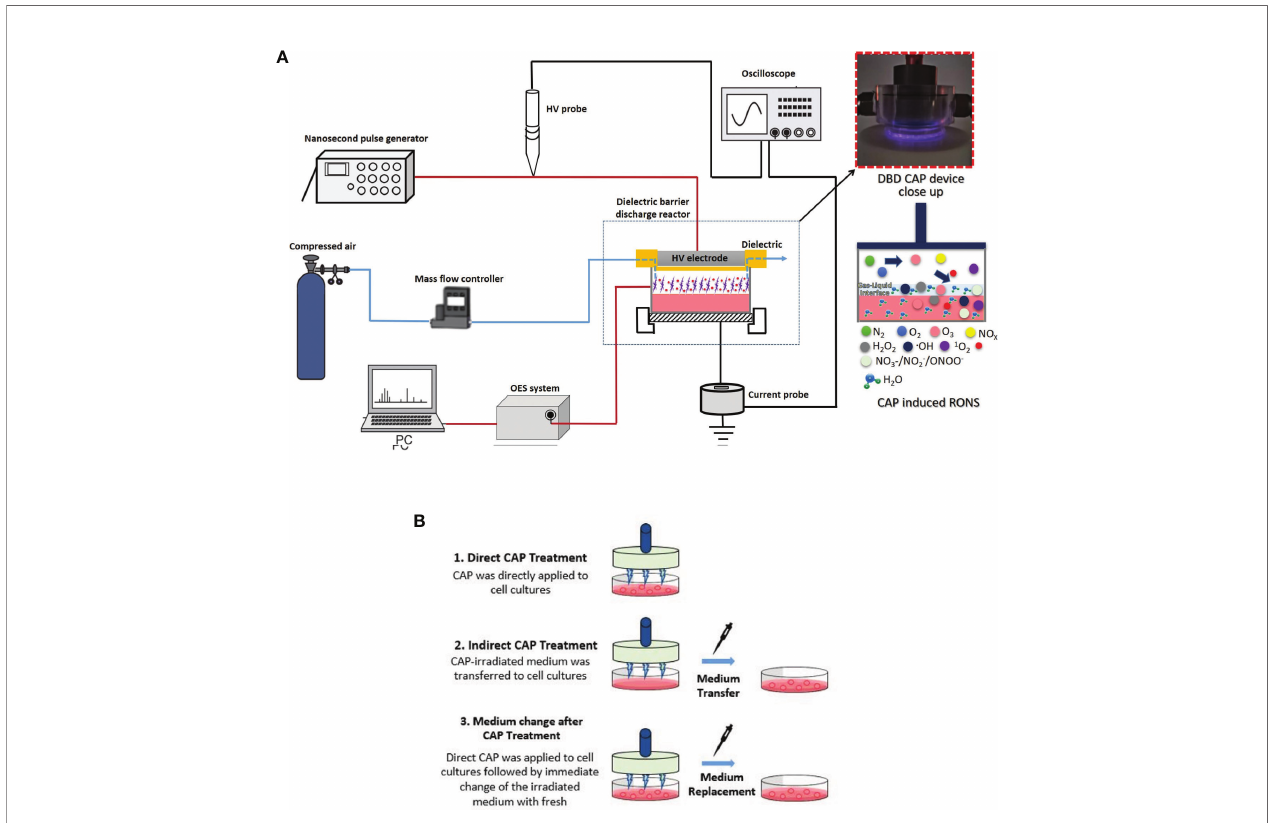
FIGURE 1 | Schematic illustration of (A) Dielectric Barrier Discharge (DBD) CAP device; (B) breast cancer cell treatment approaches: 1. Direct DBD-CAP treatment (DBD-CAP was directly applied to cell cultures); 2. Indirect DBD-CAP treatment (DBD-CAP-treated medium was transferred to cell cultures); 3. Medium change after DBD-CAP treatment (Direct DBD-CAP was applied to cell cultures followed by immediate change of the CAP-treated medium by fresh